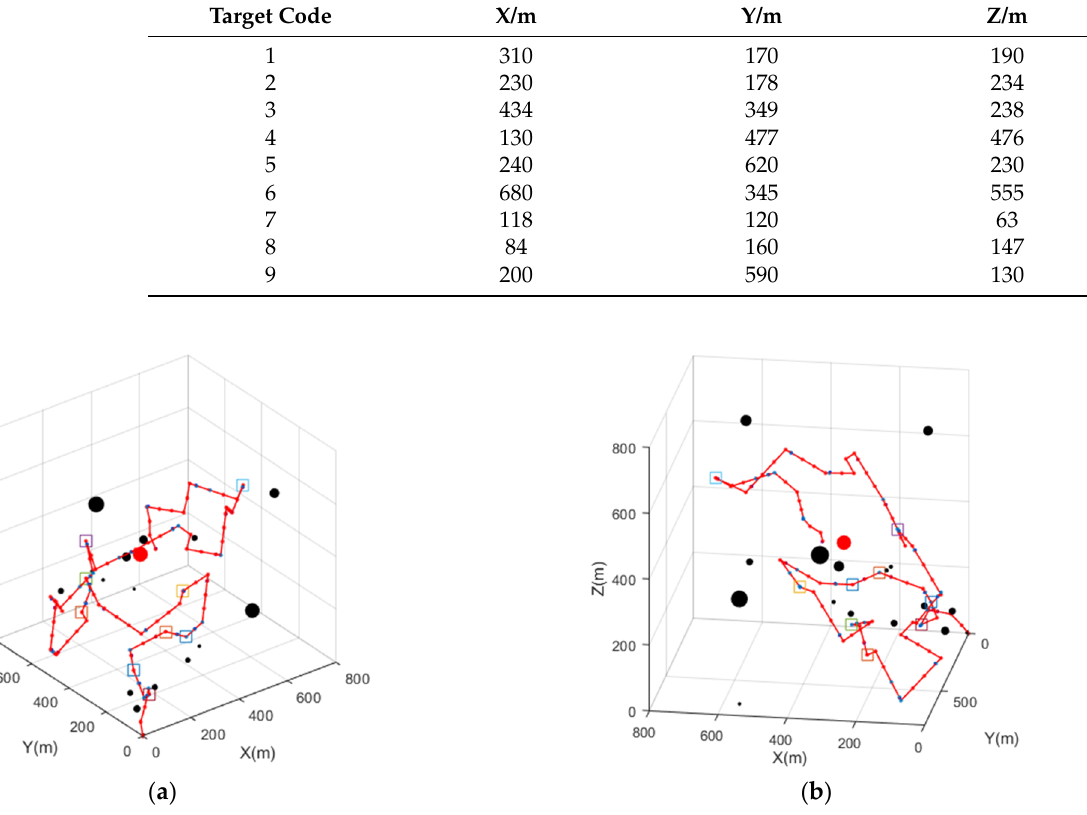
Figure 20. Different view of target interception: ( a ) view 1; ( b ) view 2.